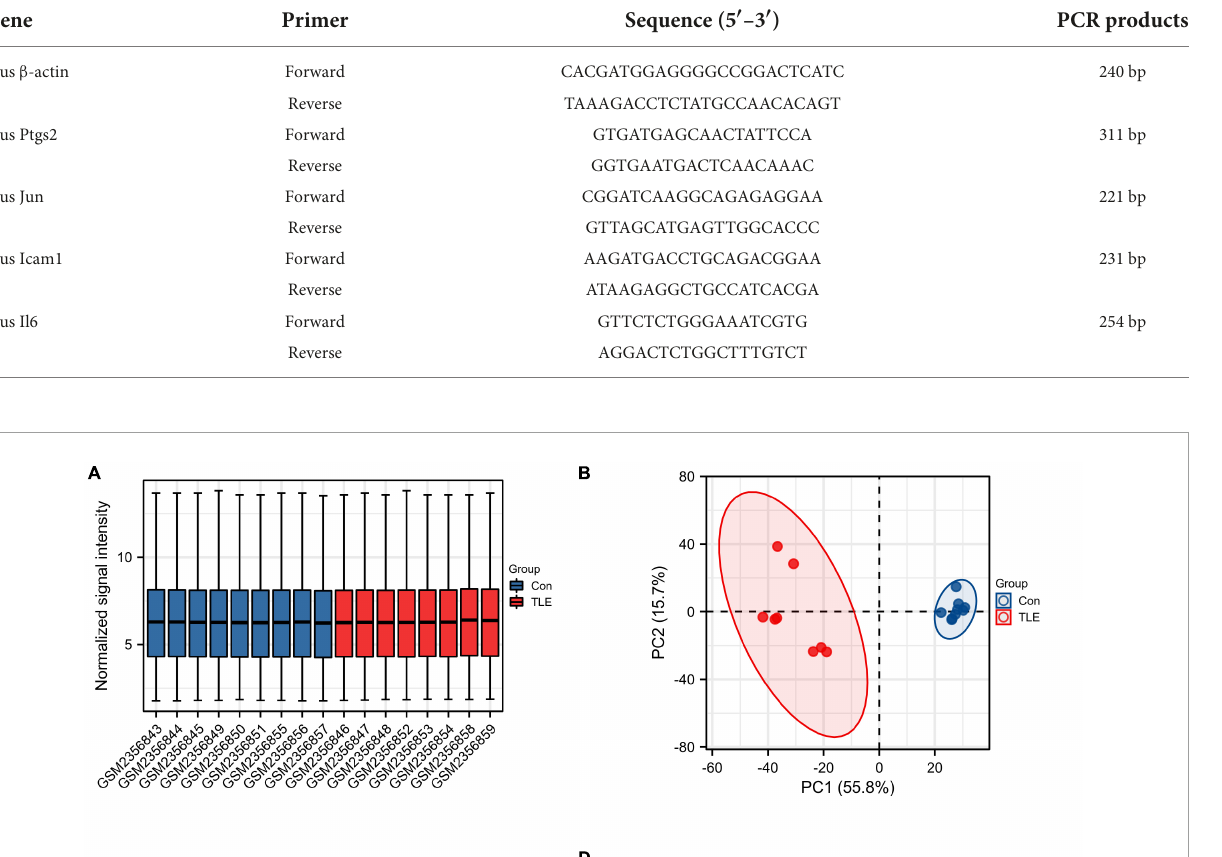
TABLE 1 Sequences of primers used quantitative real-time PCR.